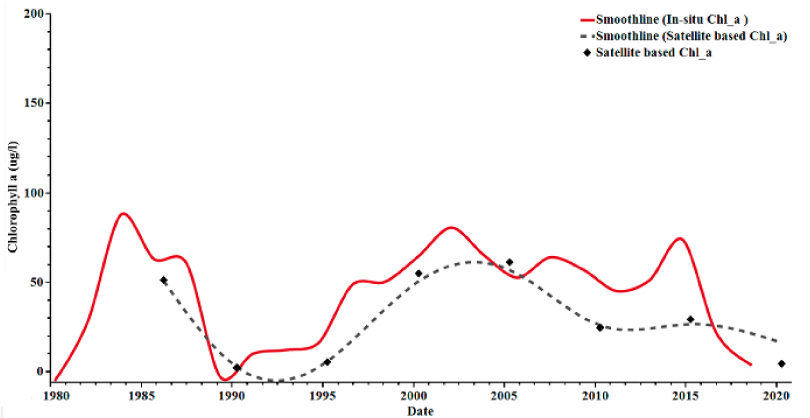
Figure 7. Time series of chlorophyll-a data retrieved from satellite and in-situ